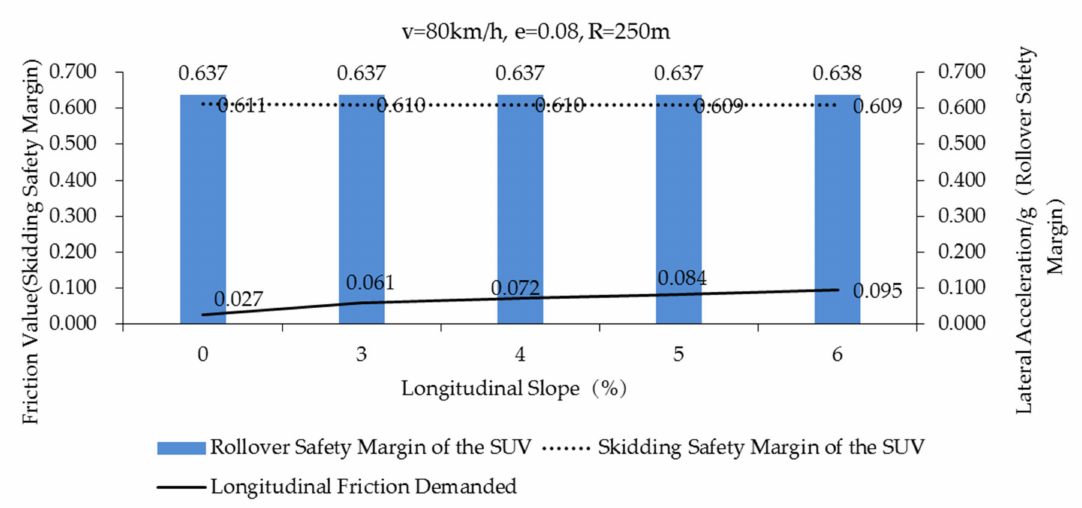
Figure 9. Skidding safety margin of the SUV, rollover safety margin of the SUV, longitudinal friction demanded of the SUV on good friction pavement ( f Tmax = 0.85) (Case 7–11, in Table 5).